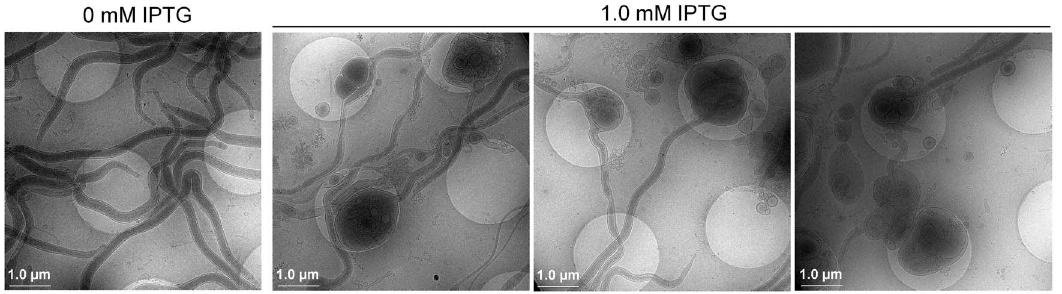
Figure 8. Spirochetes form blebs before death. D rpoS/rpoS in spirochetes were induced with IPTG at a final concentration of either 0 or 1.0 mM for 3 days and imaged using the Polara G2 electron